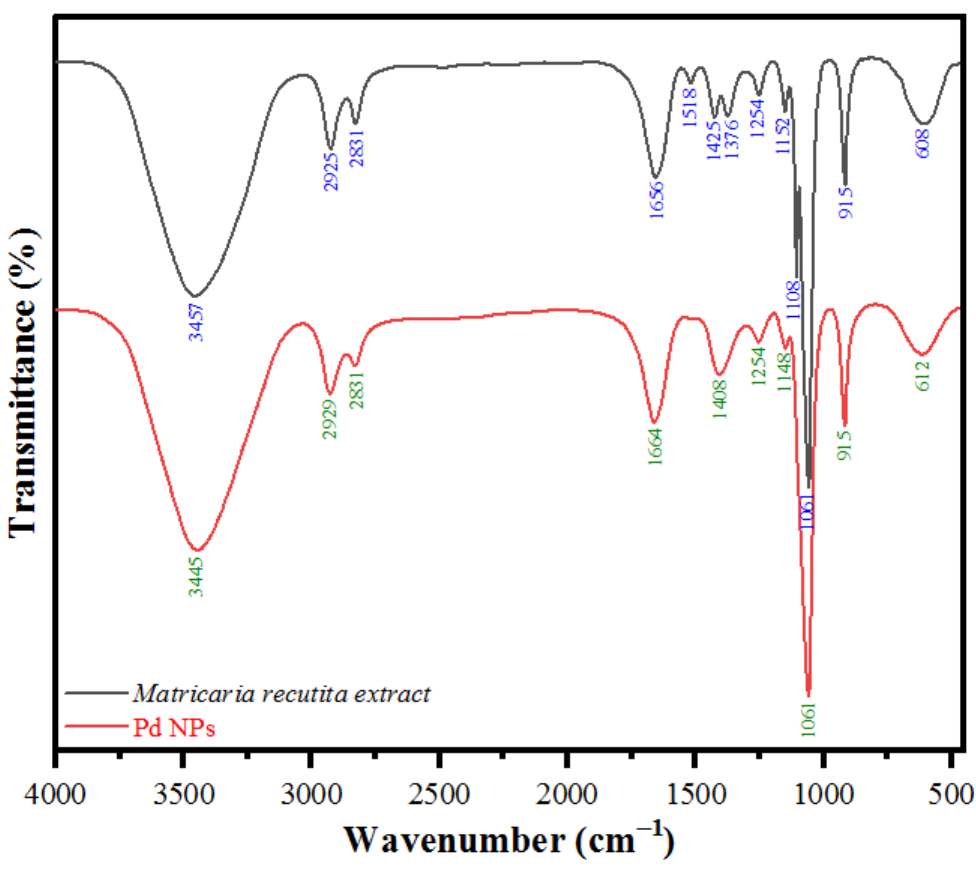
Figure 3. FT-IR spectra of PdNPs synthesized by using the flower aqueous extract of Matricaria recutita .